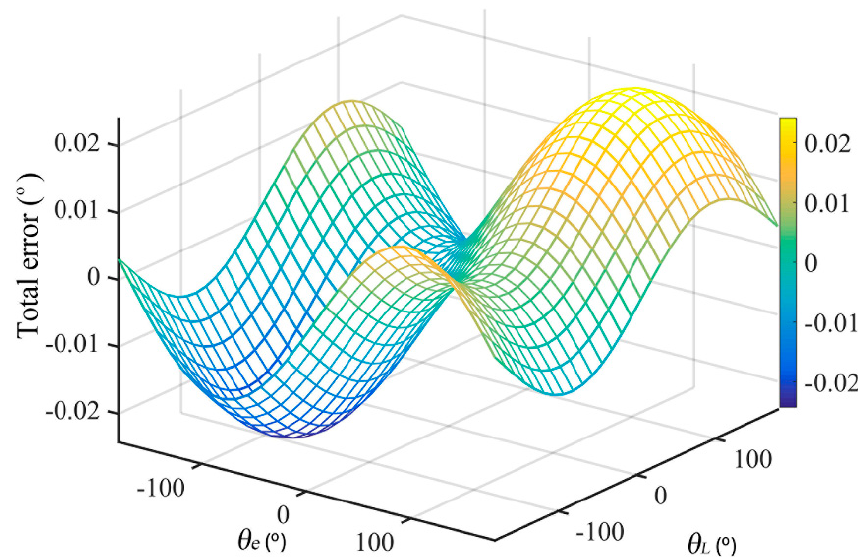
Figure 6. The total error δ varied with θ e and θ L .